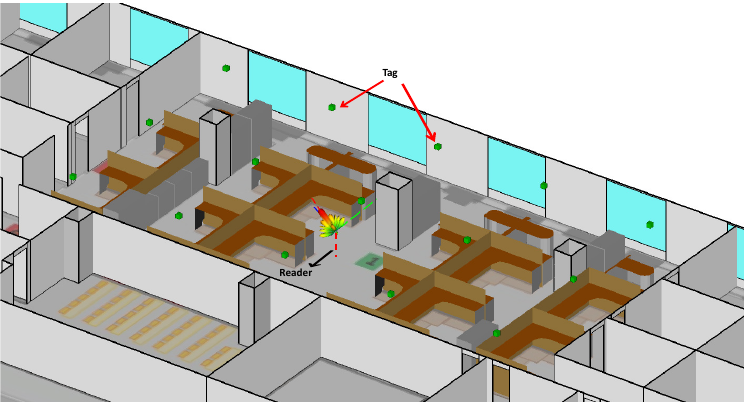
Figure 7. 3D layout of simulated real environment of the office room modeled in Wireless InSite